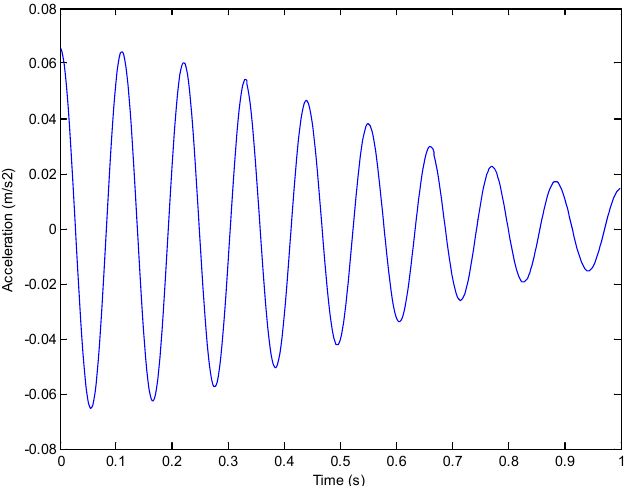
Figure 12. Free vibration curves of IMF6 obtained using the NExT method.